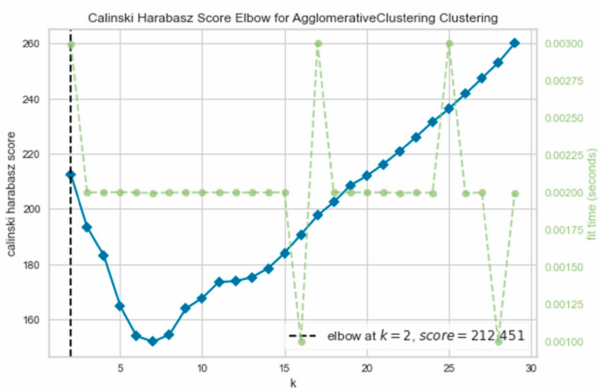
Figure 7. Calinski–Harabasz score graph for the proposed PCA-Ward while k =